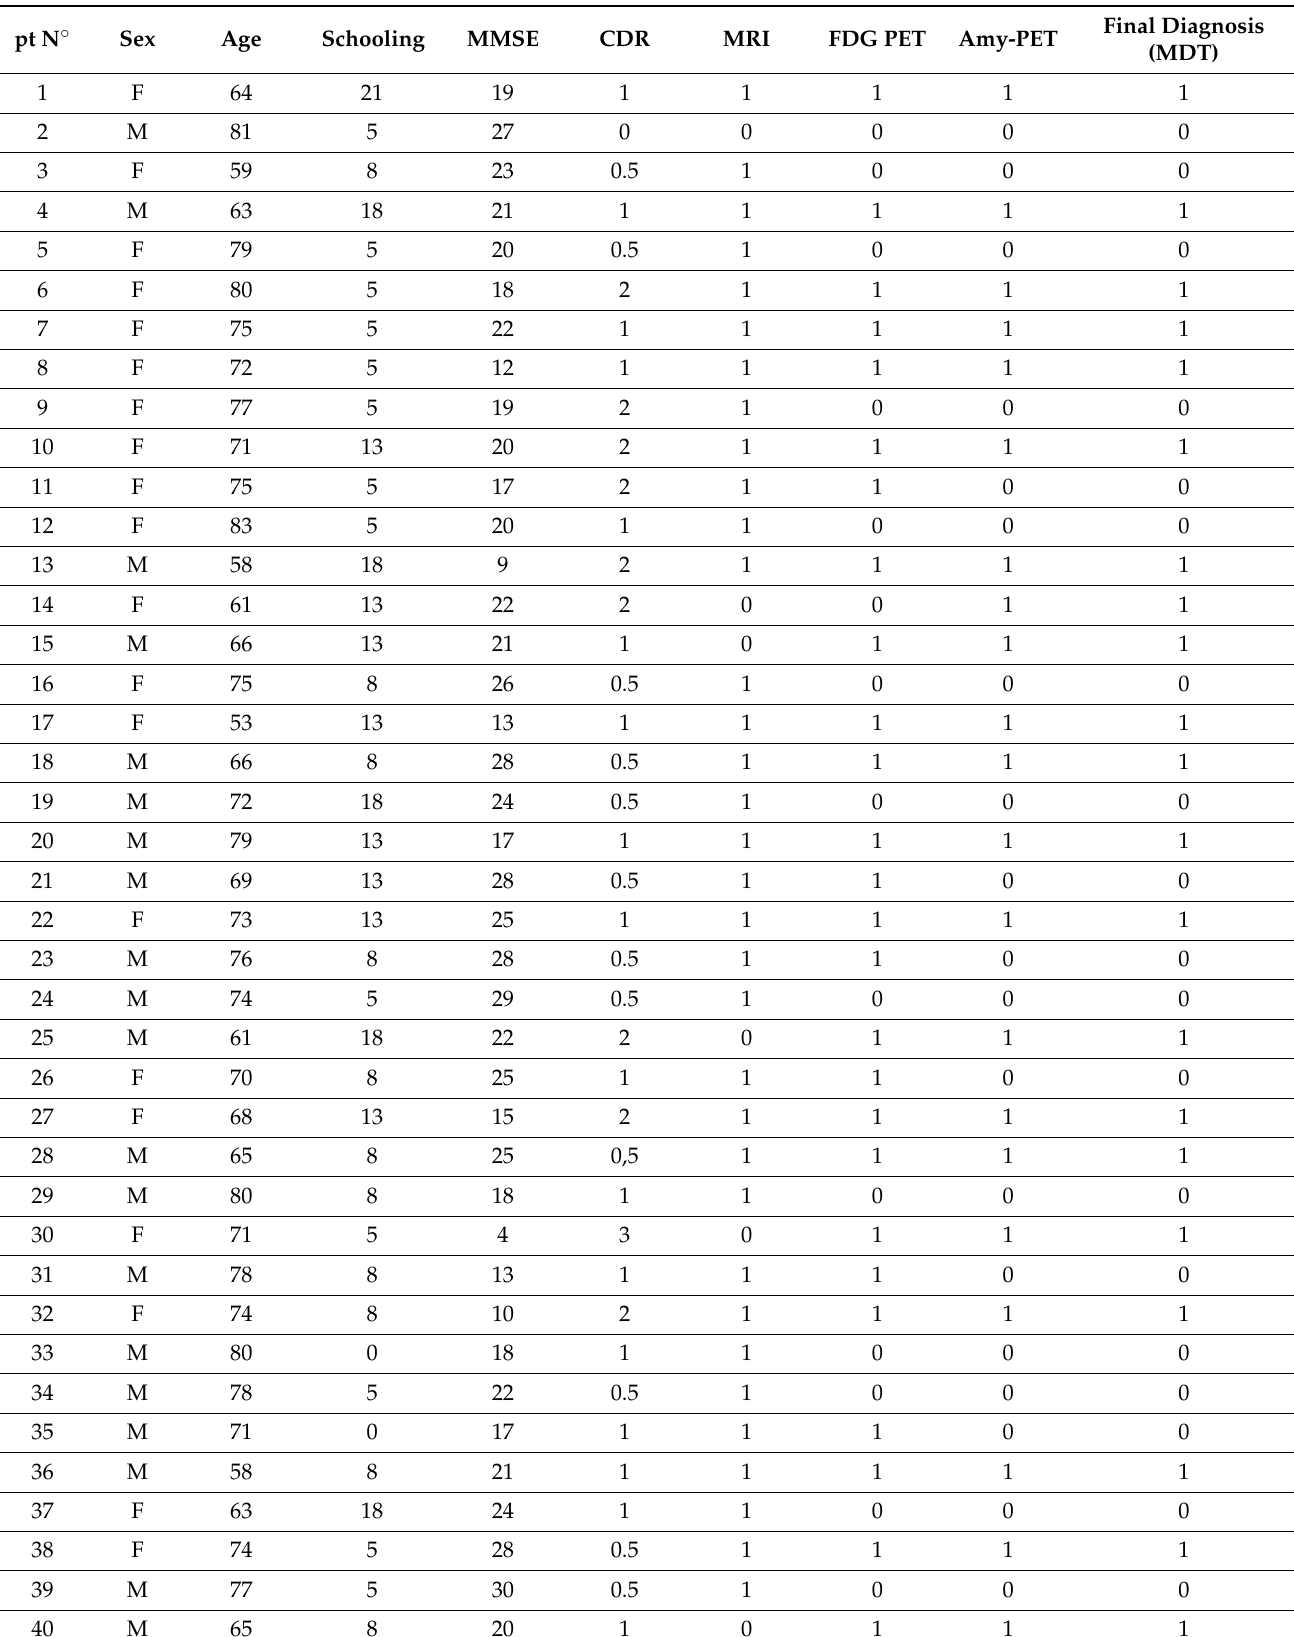
Table 2. Patients’ main